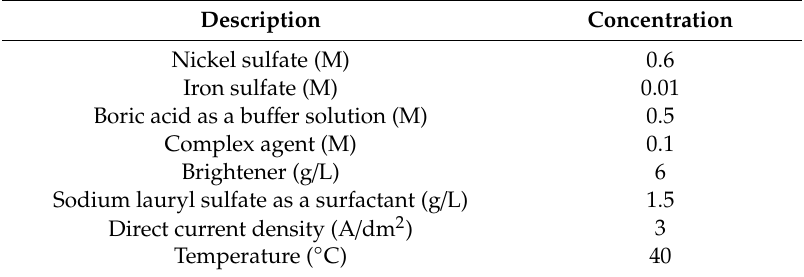
Table 2. Composition and conditions of Ni-Fe alloy electroforming